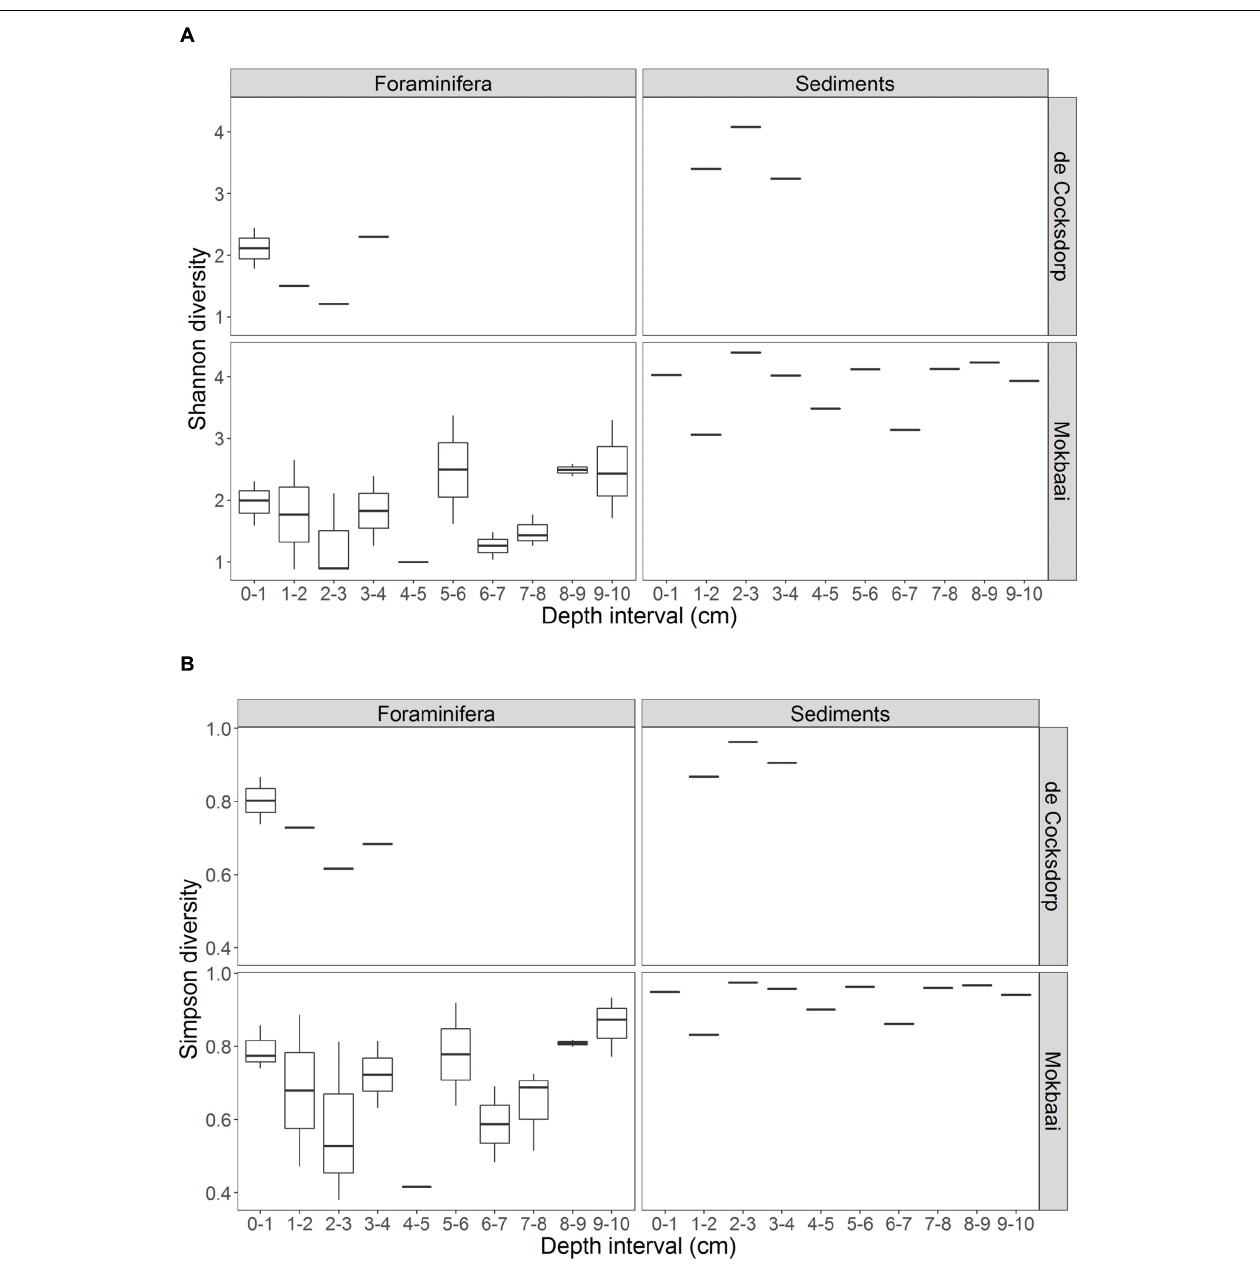
FIGURE 3 | Summary of the alpha diversity, calculated by (A) Shannon and (B) Simpson indices, of foraminiferal intracellular content (excluding foraminiferal OTUs) and sediment communities. Foraminiferal communities were grouped per depth interval. There are multiple foraminiferal specimens for each depth interval (see Table 1 , here shown by boxplots) but always one sediment sample per depth interval. Boxplots show the median (middle line) diversity; the lower and upper hinges correspond to the first and third quartiles (the 25th and 75th percentiles) of the diversity range; the upper and lower whiskers extend from the hinge to the largest and lowest value no further than 1.5 ∗ IQR from the hinge (where IQR is the inter-quartile range, or distance between the first and third